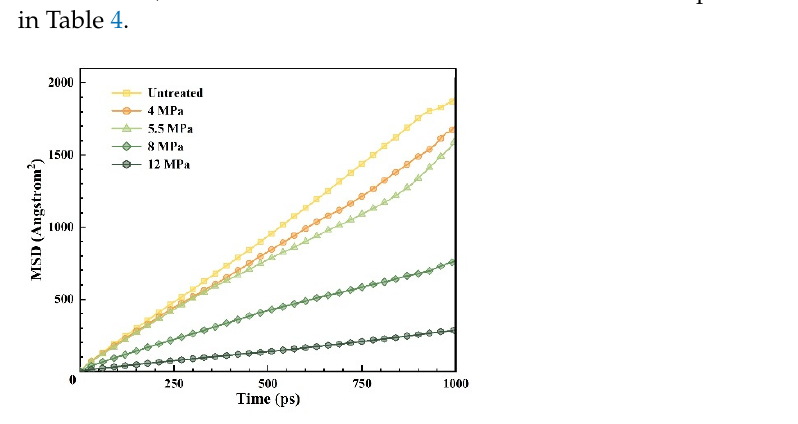
Figure 3. MSD of water–cellulose model. Table 4. Diffusion coefficients of water–cellulose model under different